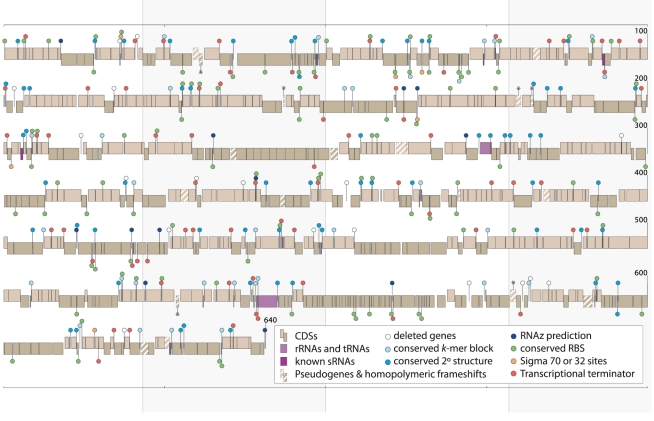
IGS features in the Buchnera-ApTokyo genome.Staggered boxes represent annotated genes located on the forward (higher) or reverse (lower) strands. The majority of the 336 long intergenic regions contain conserved sequence blocks, many with inferred functions, as indicated by the color-coded ball-and-sticks. Asterisks (*) denote newly identified pseudogenes in Buchnera-ApTokyo. Size scale is in kb.